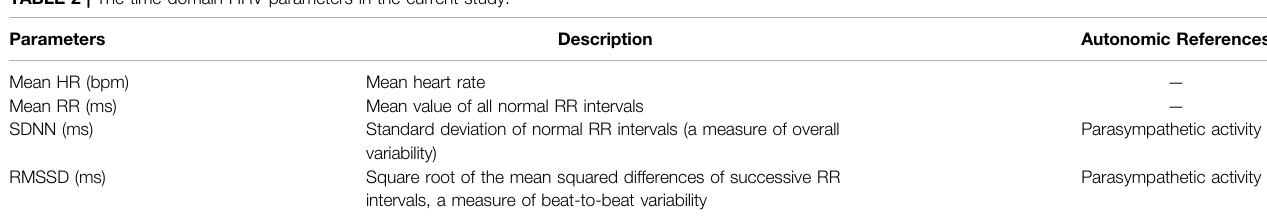
TABLE 2 | The time-domain HRV parameters in the current